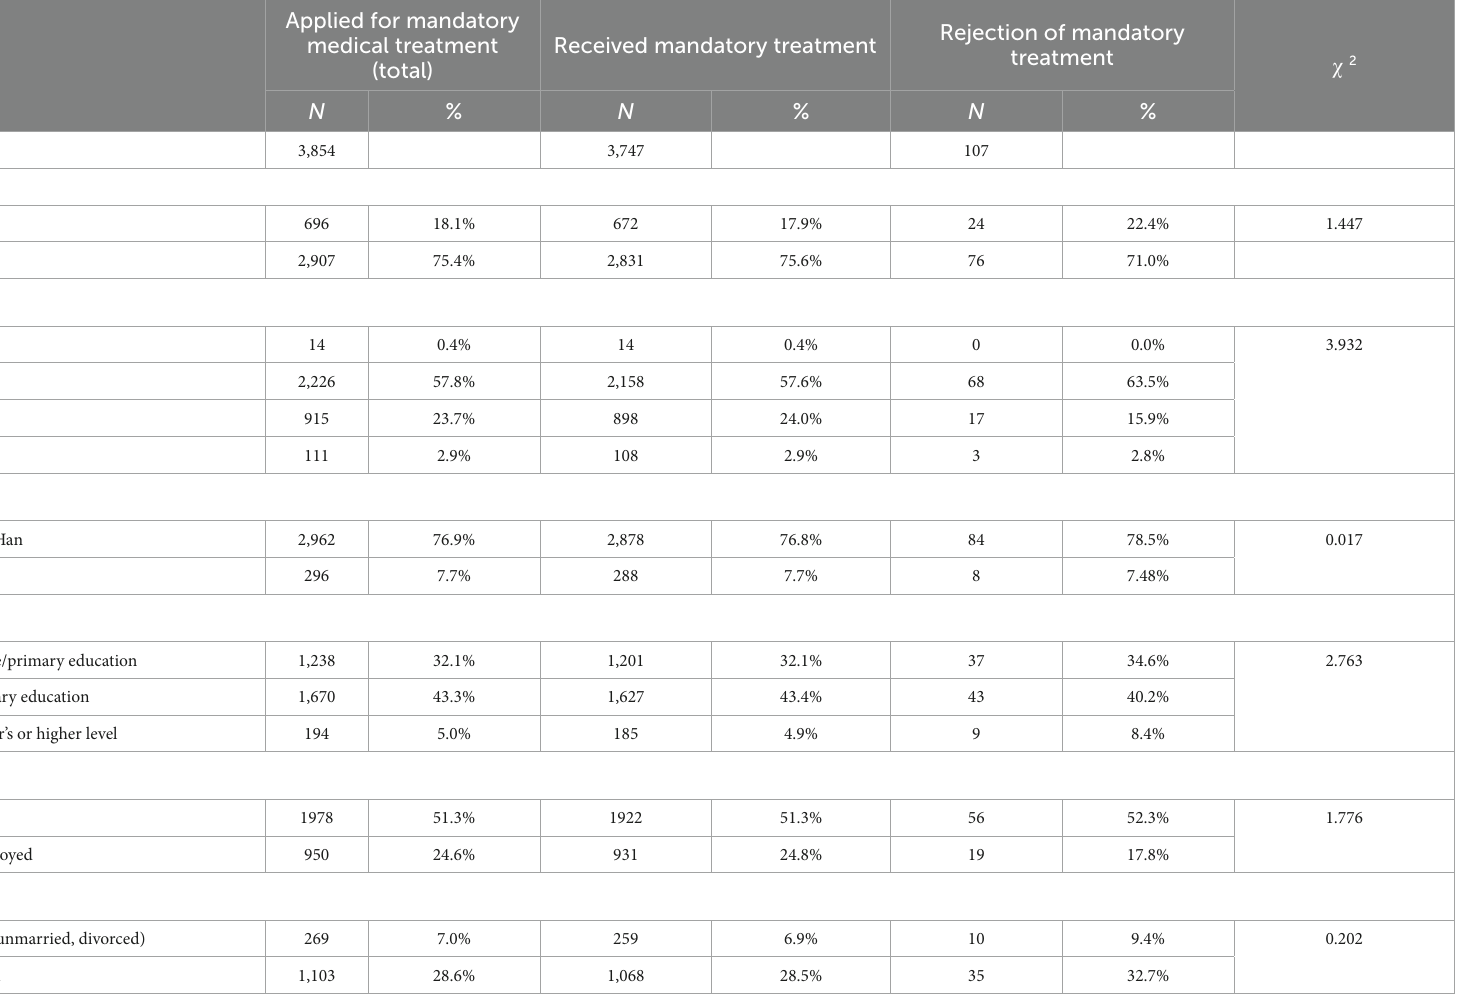
TABLE 1 Descriptive characteristics of persons for whom mandatory applications were made ( N =